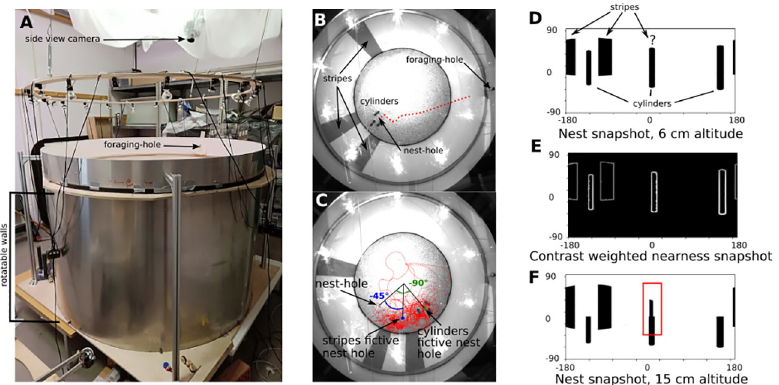
Fig 1. Experimental set-up. A: Photograph of the experimental set-up consisting of a cylindrical flight arena, a suspended ring holding part of the lighting, and a white mesh covering the camera holders (only the side camera is visible in the picture). B: Habituation condition, image from the top view camera during recording, with two of the three stripes on the arena wall placed behind the nest hole and three cylinders placed around the nest. Overlaid trajectory of a return flight during the habituation phase, red dotted line. C: Picture of a test condition, cue conflict condition -45/-90; the cylinders’ fictive nest, green circle, is placed at an angle of -90˚ from the nest hole viewed from the centre of the arena, then, the stripes’ fictive nest, blue circle, at -45˚ from the nest hole. The picture is overlaid by one sample trajectory corresponding to this cue conflict condition (red dotted line). D: Nest snapshot, equirectangular projection of the simplified bee view, taken at 6 cm above the nest hole location in the simplified rendered environment. Note that the third bar is occluded by one cylinder. E: Image of the contrast-weighted nearness nest- snapshot in the rendered environment at 6cm altitude. F: Nest-snapshot at an altitude of 15cm. The third bar is now only partly occluded.